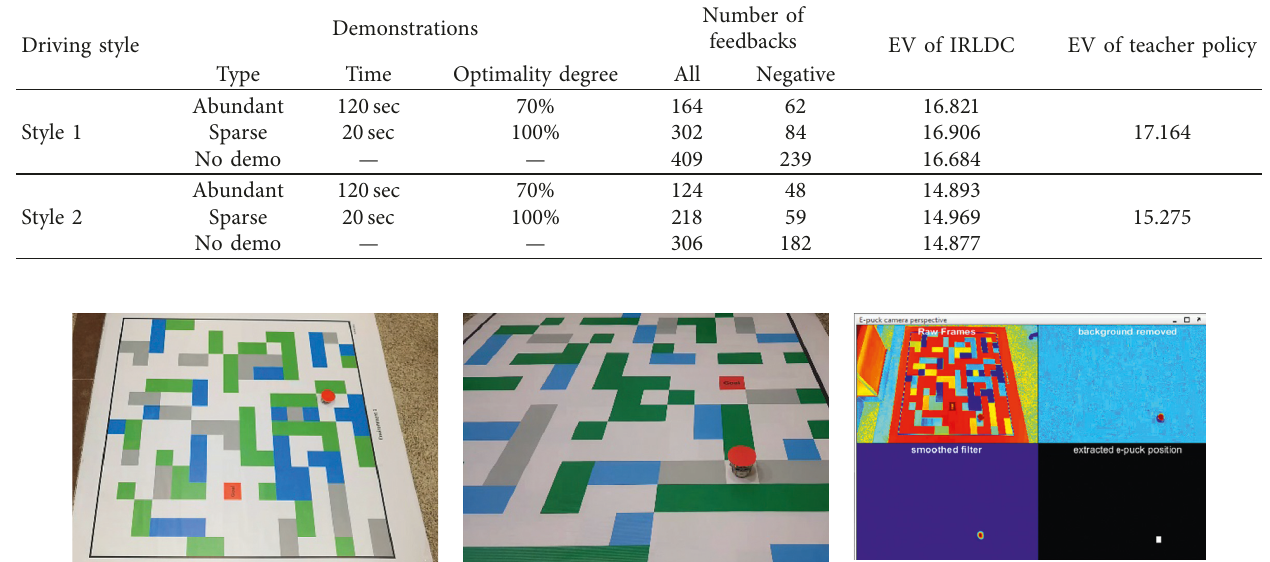
Table 3: Learning the driving styles from a human teacher in different conditions.